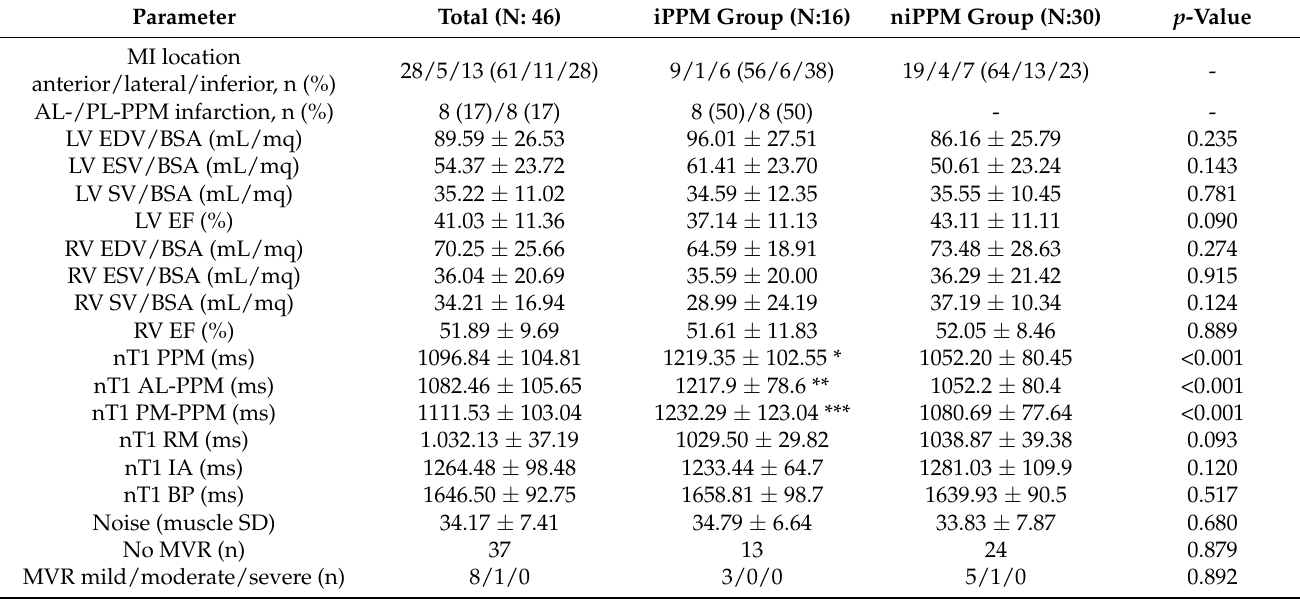
Table 2. The CMR